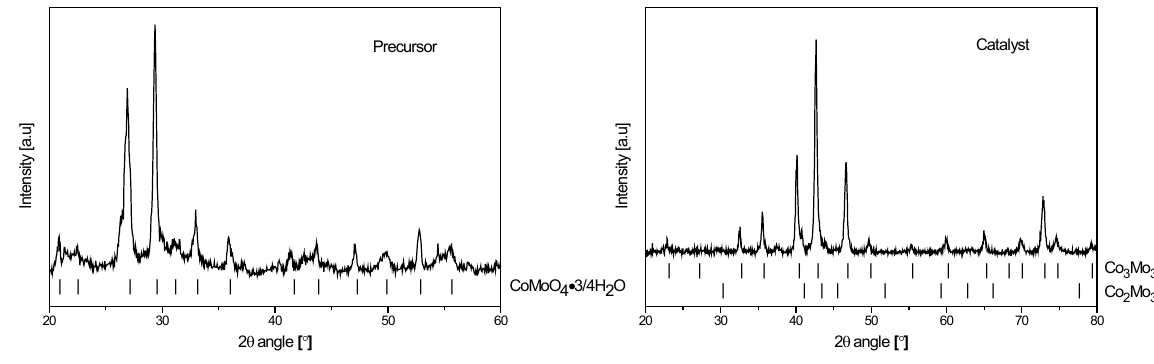
Figure 1 : X-ray diffraction pattern of the precursor containing 2.0 wt% of chromium (left) and of the same sample after ammonolysis